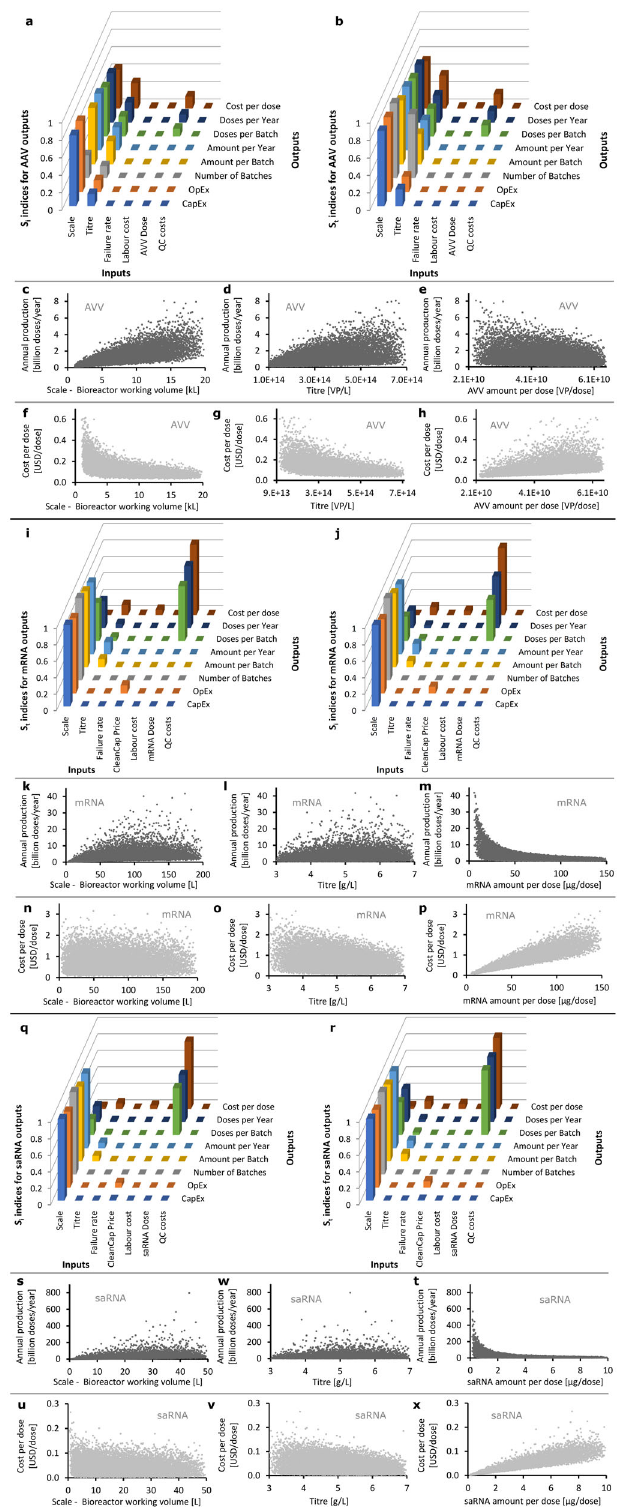
Fig. 2 Global sensitivity analysis of multiple input factors for AVV, mRNA and saRNA platforms on key performance indicators (KPIs) 27 – 29 . The input factors are scale, titre, failure rate, CleanCap purchase price (for mRNA and saRNA only), labour cost, drug substance (AVV or RNA) amount per dose, and quality control (QC) cost. The KPIs are capital costs (CapEx), operating costs (OpEx), number of batches produced per year, amount per batch, amount per year, number of doses per batch, number of doses per year (annual production amounts), and cost per dose. a – h , i – p , q – x : vaccine drug substance production performance for AVV, mRNA and saRNA platforms. a , b , i , j , q , r : fi rst-order effect (S i ) and total effect (S t ) sensitivity indices for the KPIs versus each input factor for the AVV, mRNA and saRNA platforms. Large S i and S t values indicate a